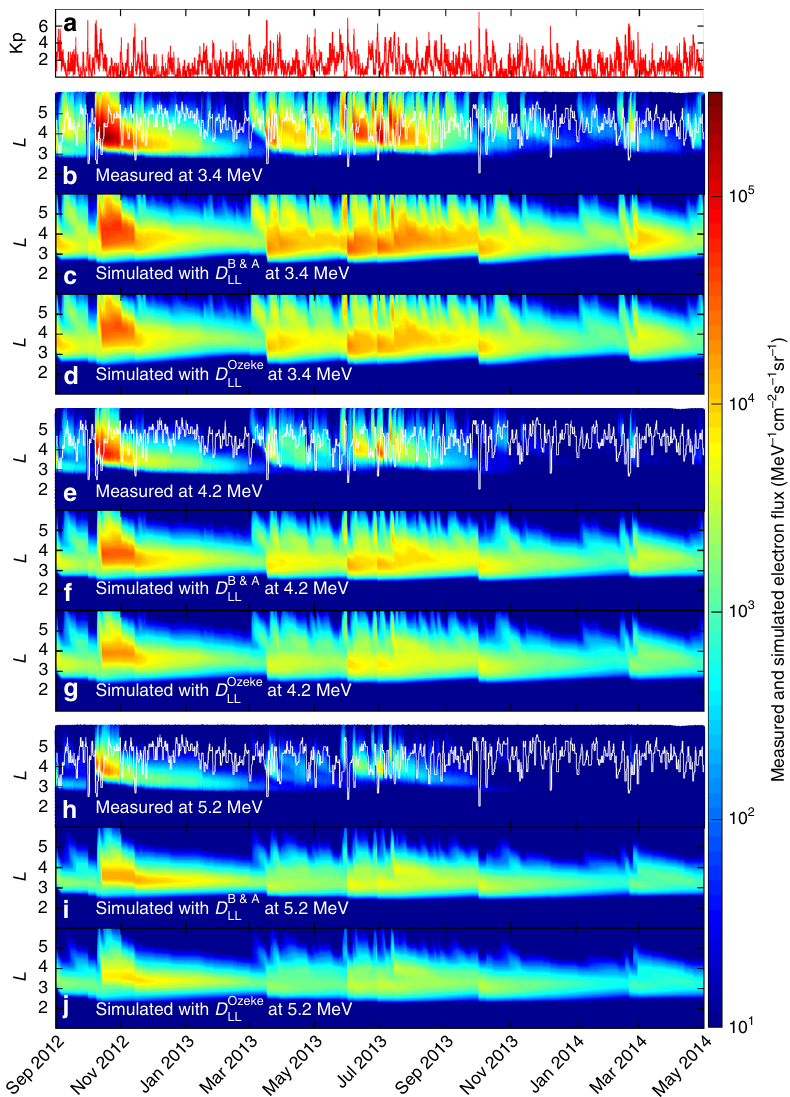
Fig. 1 Measured and simulated ultra-relativistic electron fl ux from September 2012 to May 2014. The time series of Kp during this interval is shown in a . b The 3.4 MeV electron fl ux measured with the REPT instrument on Probes A and B during this time interval. c , d The simulated electron fl ux at a fi xed energy of 3.4 MeV produced using a radial diffusion model applying the empirical radial diffusion coef fi cients from D LL [B & A] 24 and D LL [Ozeke] 4 , respectively. Both these radial diffusion coef fi cient models are functions of the Kp values shown in a . Similar measured and simulated electron fl ux results are also shown at a fi xed energy of 4.2 MeV in e , f , and g , and at a fi xed energy of 5.2 MeV in h , i , and j . The location of the plasmapause derived from the Carpenter and Anderson 21 model is also over-plotted on the measured electron fl ux illustrated by the white curve in b , e , and